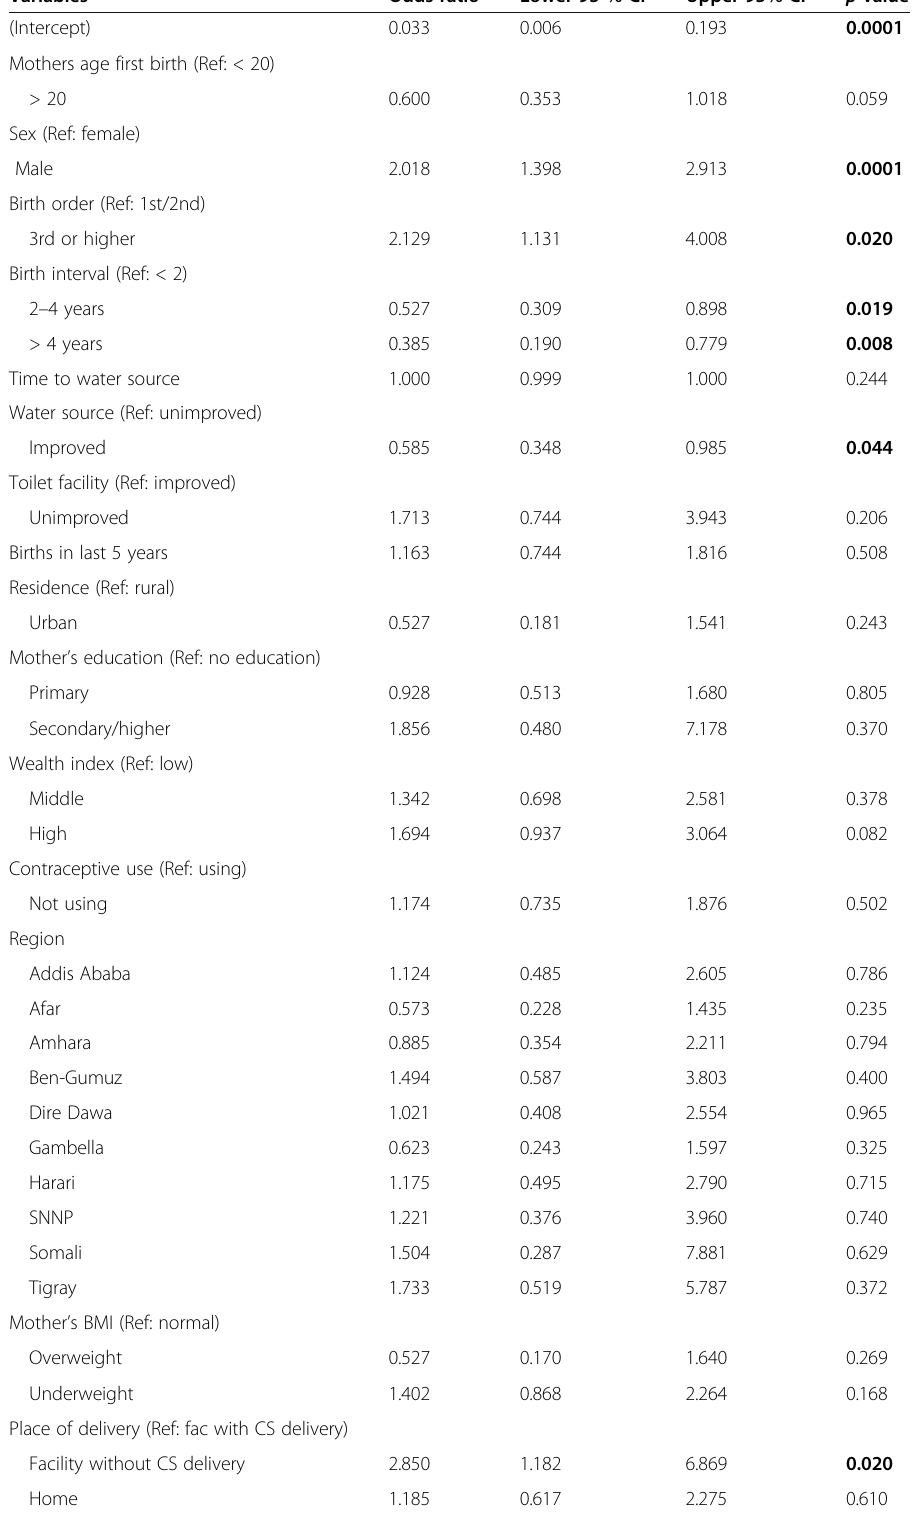
Table 3 Logistic regression analysis of under-five mortality in Ethiopia